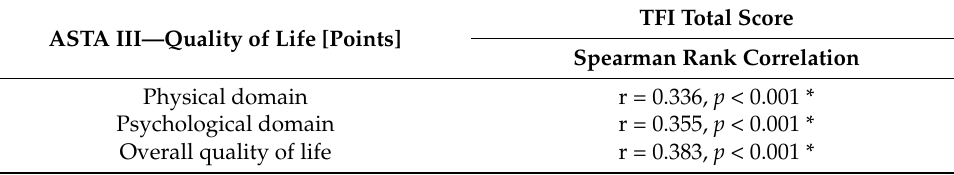
TFI Total Score Spearman Rank Correlation